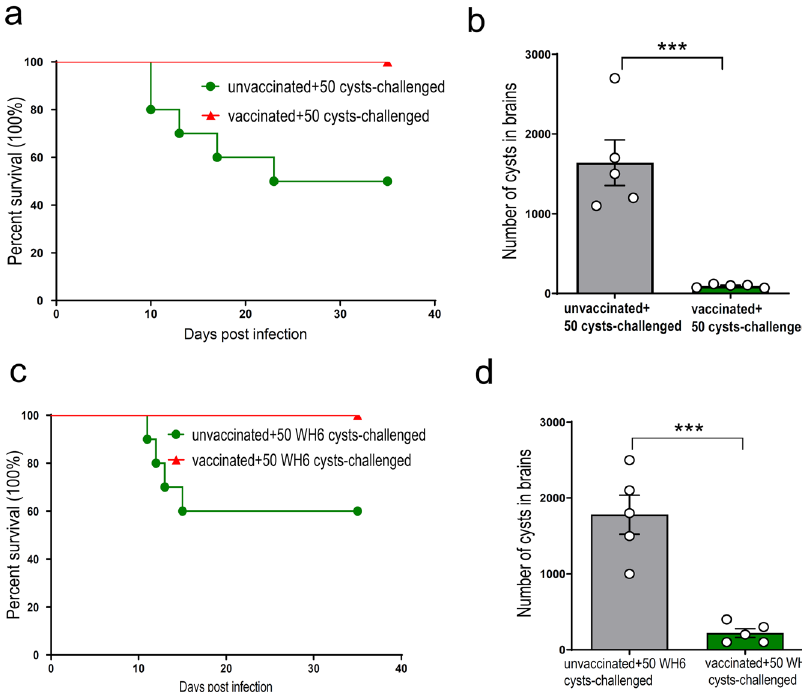
Fig. 5 ME49 Δ cdpk3 vaccination protected mice against different cysts infection. a The survival rate of vaccinated or unvaccinated mice with 50 cysts of ME49 strain was monitored ( n = 10 each group). b At 35 days post-infection with ME49 cysts, surviving unimmunized and immunized mouse brains were isolated to assess the number of cysts ( n = 5 each group). The statistical analysis was performed by using unpaired t test. Bars = mean ± SEM. *** p < 0.001. c The survival rate of vaccinated or unvaccinated mice with 50 cysts of WH6 strain was monitored ( n = 10 each group). d At 35 days post-infection with WH6 cysts, surviving unimmunized and immunized mouse brains were isolated to assess the number of cysts ( n = 5 each group). The statistical analysis was performed by using unpaired t test. Bars = mean ± SEM. *** p <